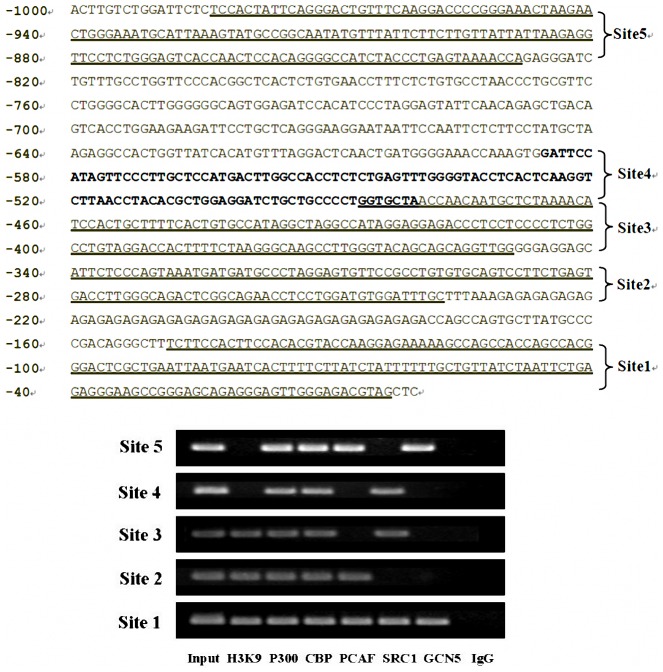
Acetylation sites of HATs on the Gata4 promoter.The sequence of 1.0 kb at up-stream of the transcription start site of mouse Gata4 is indicated in Upper and band density is in the bottom. ChIP-PCR results run on agarose gel electrophoresis showed that five HATs (P300, CBP, PCAF, SRC1 and GCN5) proteins could bind to multiple sites on the promoter of Gata4 for possible acetylation of histone H3K9 on this site. All the five HATs (P300, CBP, PCAF, SRC1 and GCN5) were amplified with DNA fragments precipitated by anti-P300, anti-CBP, anti-PCAF, anti-SRC1 and anti-GCN5 antibodies. H3K9 and IgG were amplified with DNA fragment precipitated by anti-H3AcK9 antibody during the later with normal mouse IgG. Site 1: 43801992 bp∼43802137 bp, Site 2: 43802226 bp∼43802328 bp, Site 3: 43802338 bp∼43802475 bp, Site 4: 43802469 bp∼43802574 bp, Site 5: 43802817 bp∼43802972 bp.